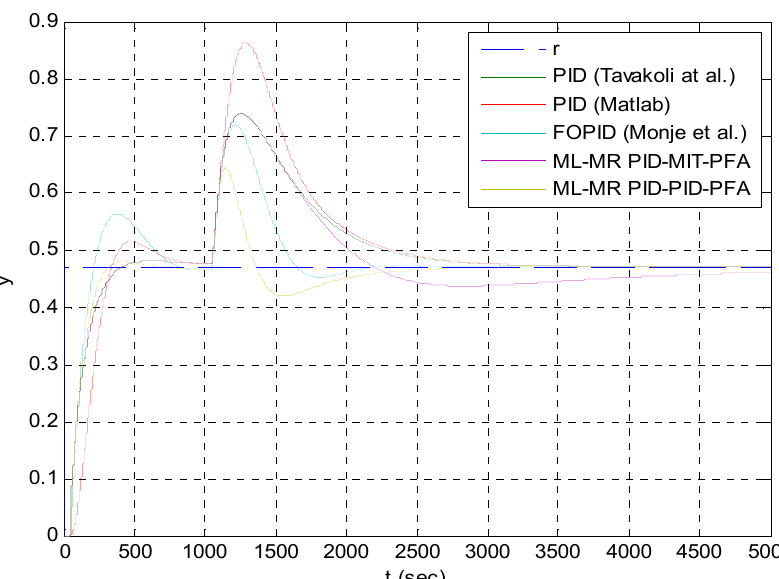
Figure 17. Control performance of various control systems for robust performance optimal control of a large time delay plant model [34].